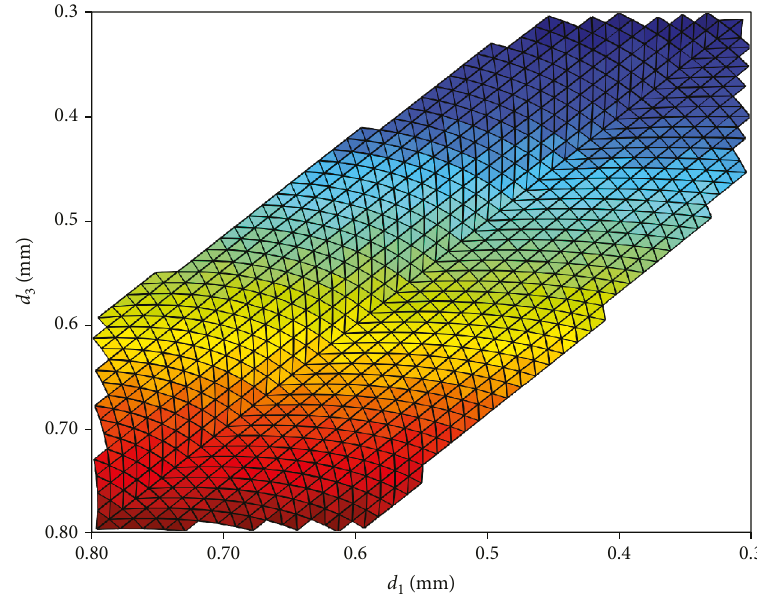
Figure 10: The two-dimensional view of the joint space of the parallel